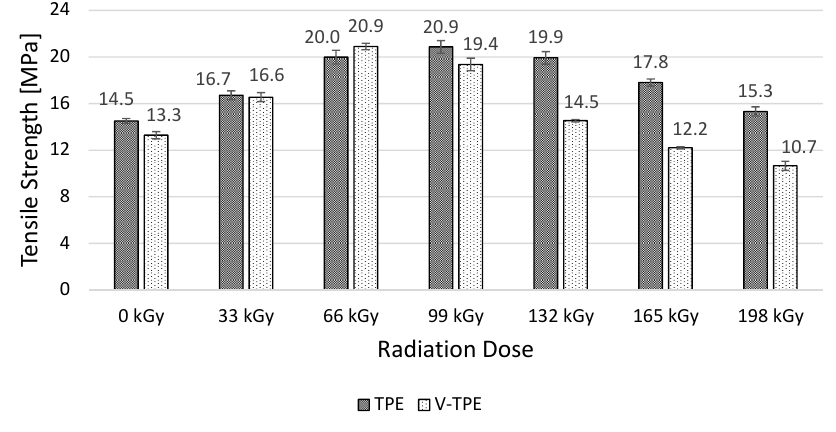
Figure 9. Tensile Strength—TPE,